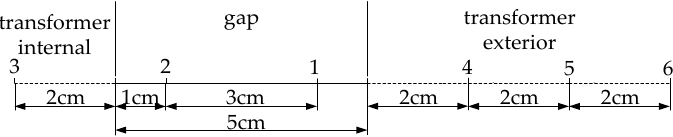
Figure 16. Layout of the detection point of experiment (transformer gap is high 3 cm and deep 5 cm).